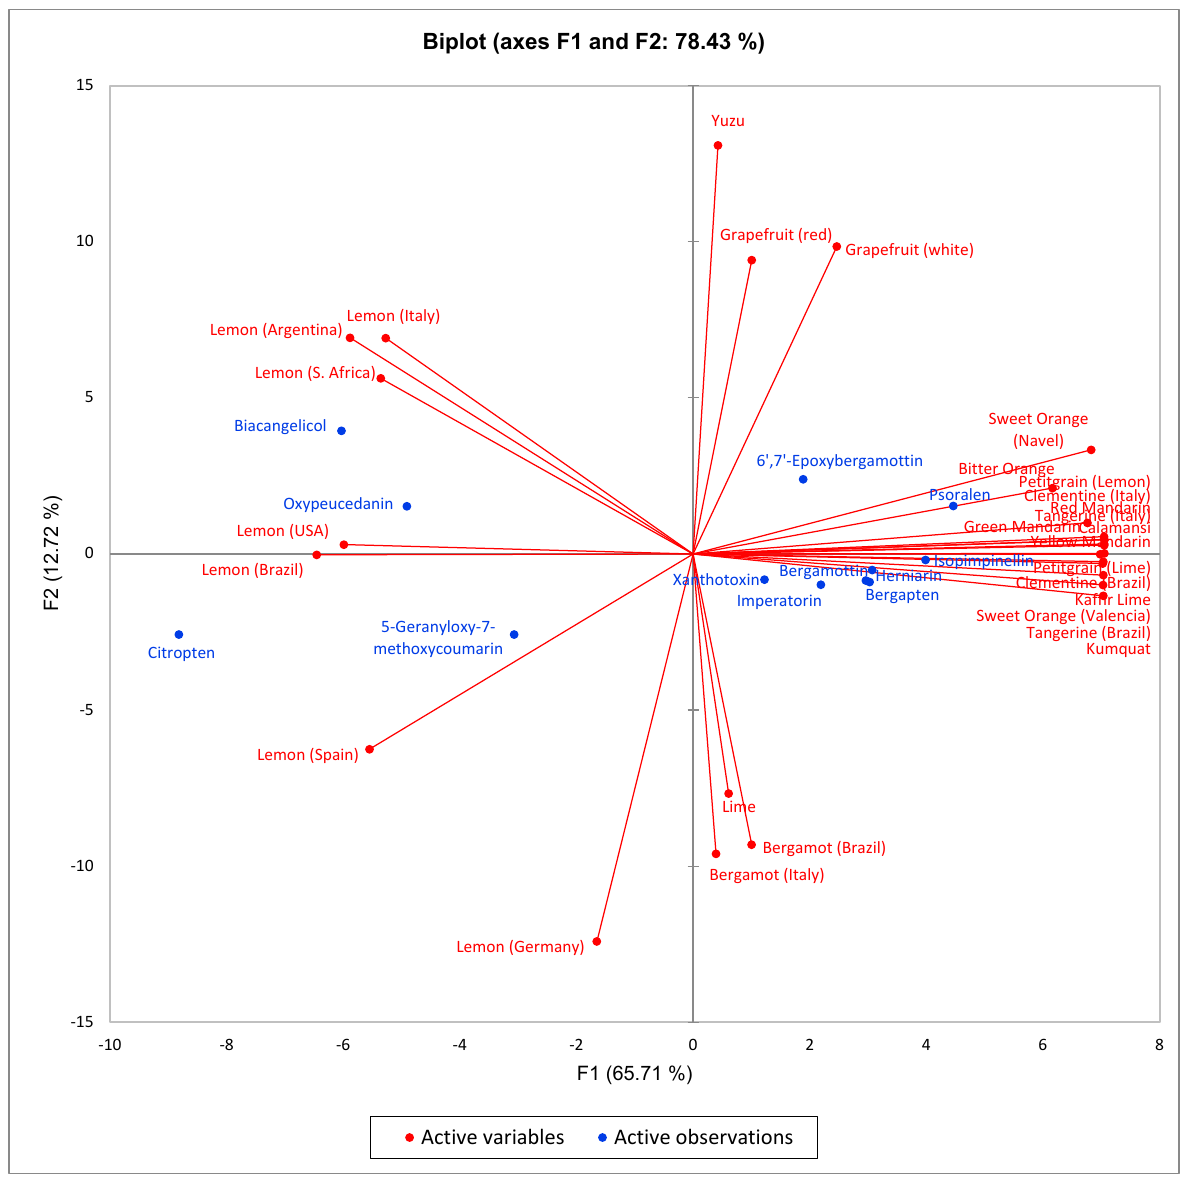
Figure 4. Principal component biplot of PC1 and PC2 scores and loadings indicating the coumarin chemical relationships of Citrus essential oils.